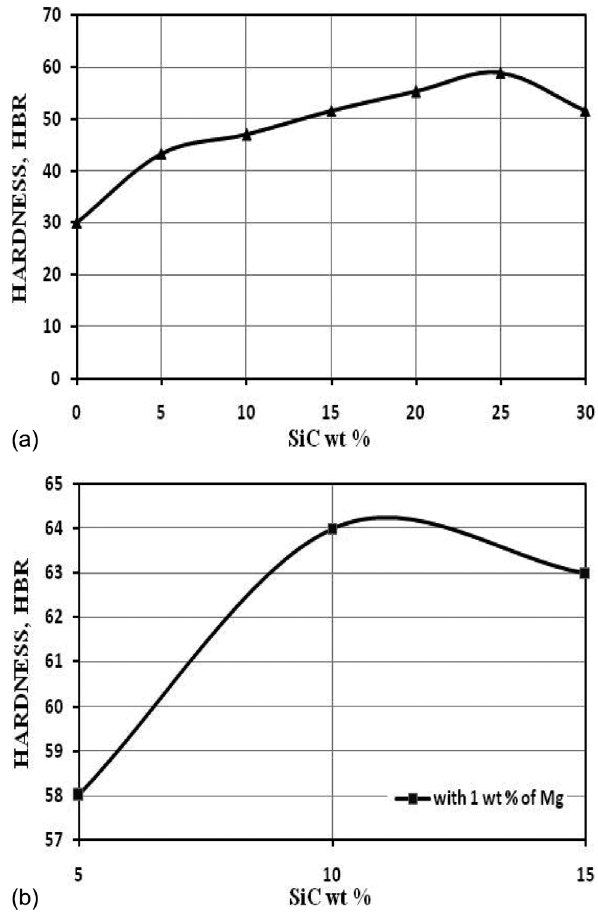
Fig. 8: (a) Variation in Hardness of the composites with wt% of SiC. (b) Hardness of the composites v/s wt% of SiC with 1 wt% of